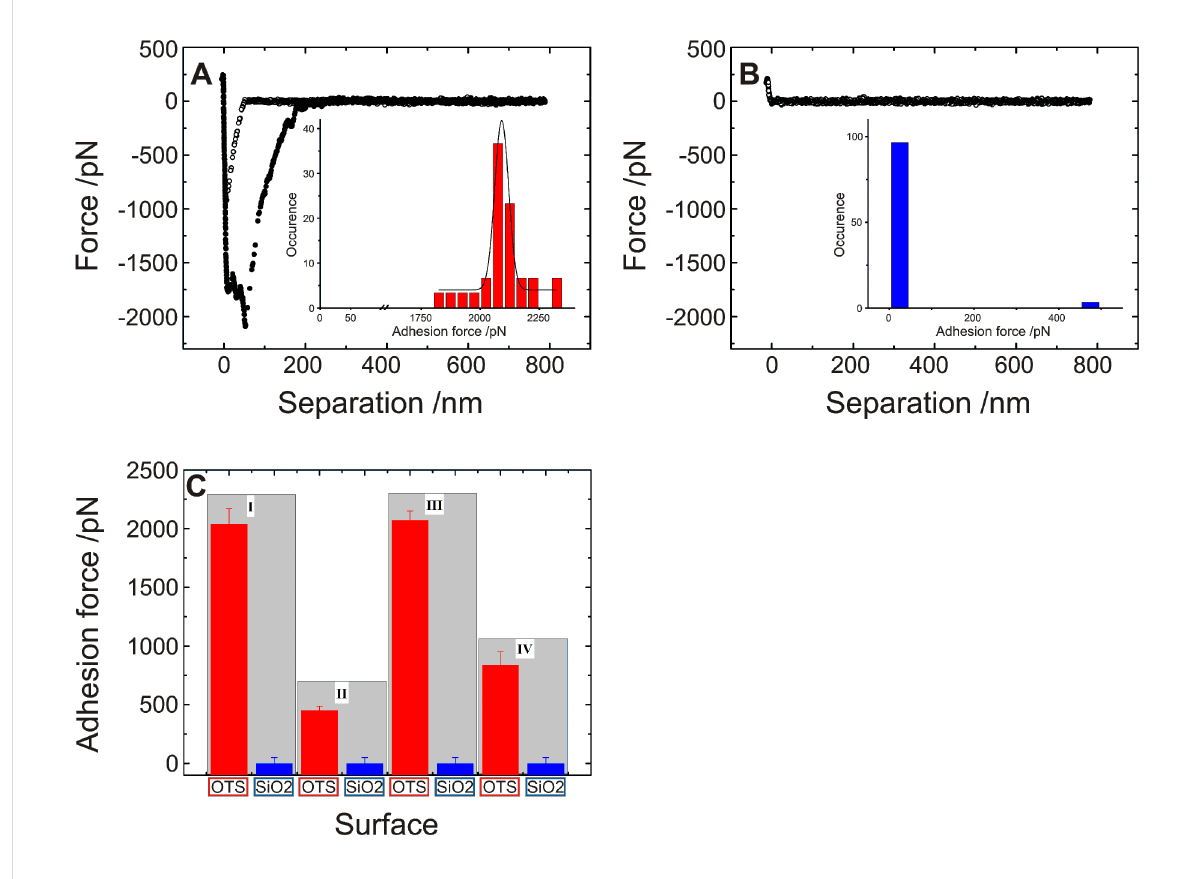
Figure 7: Exemplary force/distance curve taken with a single S. carnosus probe on (A) a hydrophobic OTS-covered Si wafer and on (B) a hydrophilic Si wafer. The insets summarize the results of the adhesion force of 30 force/distance curves. (C): Mean adhesion force and standard deviation showing the result of at least 60 force/distance curves of four S. carnosus (I–IV) measured on hydrophobic OTS-covered and on hydrophilic Si wafers, covered by a natural SiO 2 . Each of the four bars represents measurements of the exact same bacterial